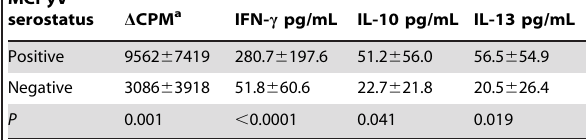
Table 2. Comparison of MCPyV-specific proliferation and cytokine responses among MCPyV seropositive and –seronegative subjects at 2.5 m g/ml antigen concentration.